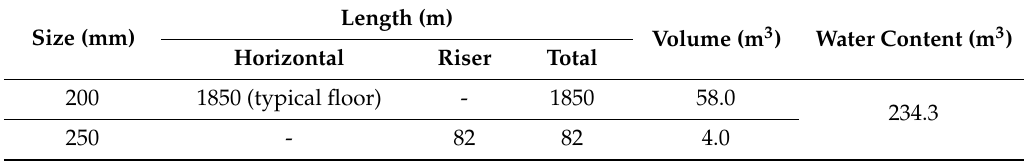
Table 3. Water content in chilled water